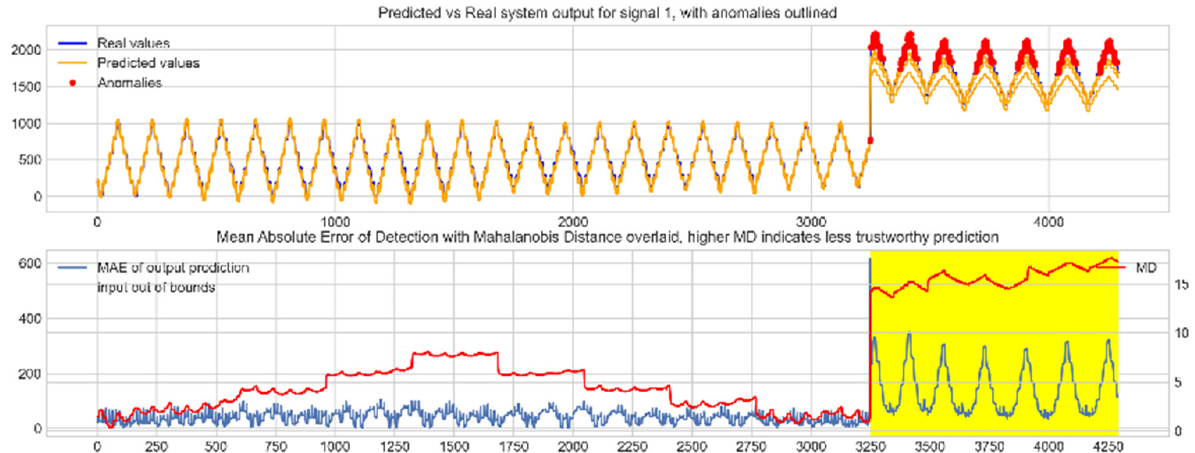
Figure 16. Predicted vs. real device input for signal 3, the motor power, with anomalies labelled ( top ); MAE, MD and boundary check corresponding with the prediction ( bottom ).